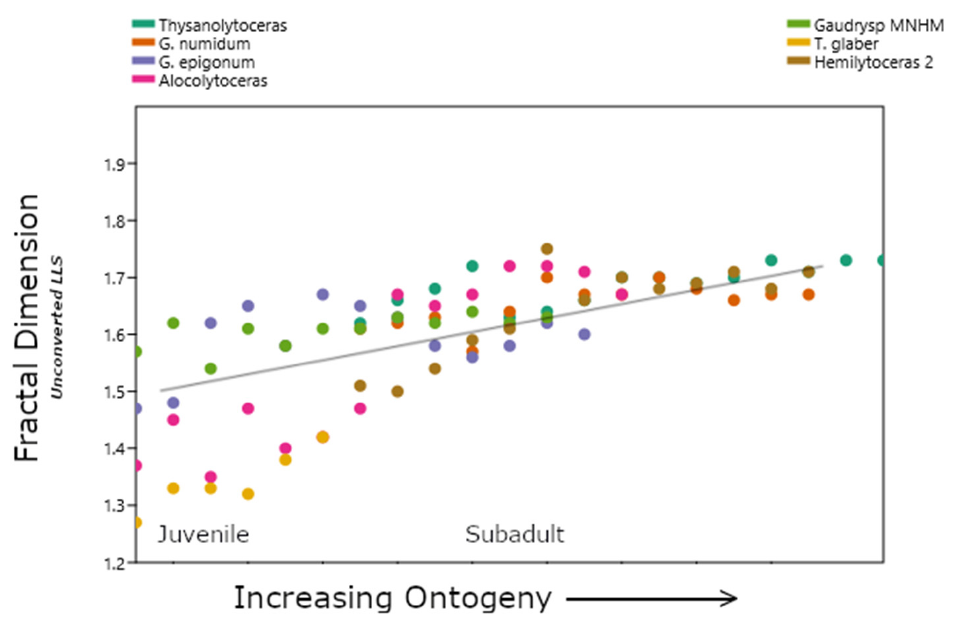
Figure 4. Decrease in variance in suture complexity over ontogeny for Lytoceratoidea, including Jurassic lytoceratids and Cretaceous gaudryceratids.